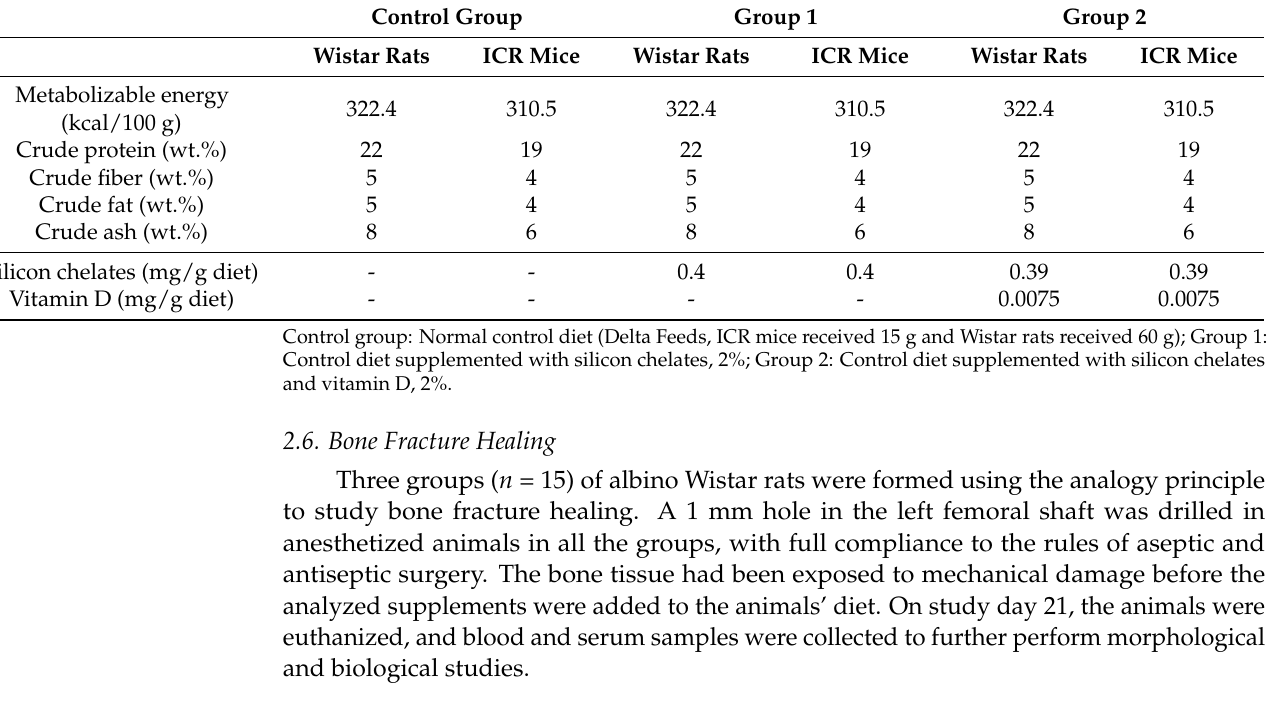
Table 1. The composition of diets used to study the effect of supplements on bone turnover in animals with physiologically induced decalcification and injuries. Animals in the control group received food without any supplements. Control Group Group 1 Group 2 Wistar Rats ICR Mice Wistar Rats ICR Mice Wistar Rats ICR Mice